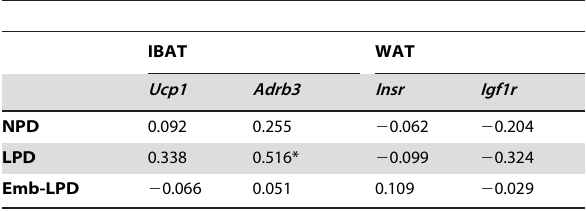
Table 9. Correlations (r values) of total fat pad weigh with relative real-time RT-PCR expression values from interscapular brown adipose tissue (IBAT) and retroperitoneal white adipose tissue (WAT).